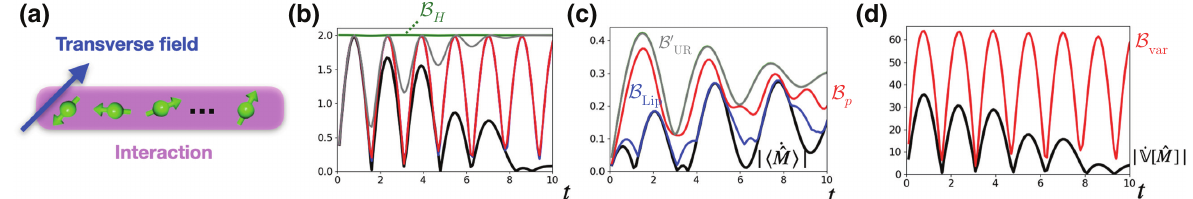
FIG. 10. (a) Schematic figure of the many-body spin system in Eq. (88). The spins consist of the spin-conserving interaction for the ˙ˆ entire spins and the transverse magnetic field only at the first site. (b),(c) Speed of the magnetization, (cid:3) M (cid:4) (black), and the speed limits from the initial states (b) | (cid:14) 1 (cid:4) and (c) | (cid:14) 2 (cid:4) . The bounds are given by B Lip (blue), B p (red), B H (green), and B (cid:16) (gray). The speed limits UR ˙ˆ can qualitatively capture (part of) the oscillations of |(cid:3) M (cid:4)| and provide nice bounds for certain times, such as t (cid:11) p π/ 2 ( p = 1, 2, . . .) for B Lip and B p from | (cid:14) 1 (cid:4) . Note that some of the curves are almost overlapped ( B Lip (cid:11) B p for | (cid:14) 1 (cid:4) and B H (cid:11) B (cid:16) for | (cid:14) 2 (cid:4) ). (d) Time UR evolution of the macroscopic coherence measured by the variance V [ ˆ M ] (black) and its bound B var (red) from the GHZ state | (cid:14) 3 (cid:4) . We find that the bound works well especially for t (cid:11) p π/ 2 ( p = 1, 2, . . .) . We consider the case with L = 10, J x = J y = 0.1, J z = 0.05, and h = 1 for all of the